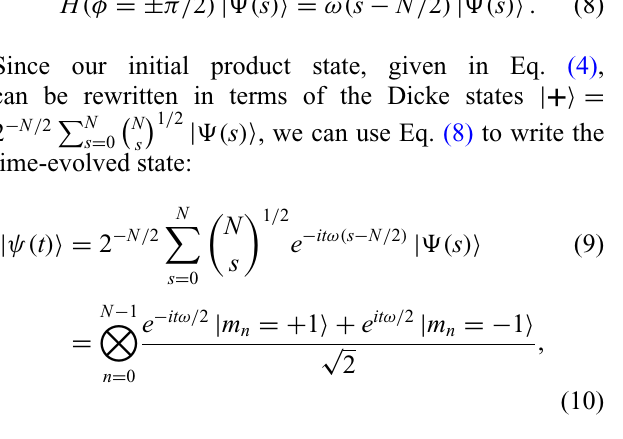
FIG. 2. (a) The optimized error δω ∗ , calculated numerically for the d = 1 example with λ n . n (cid:10) = λ/( n − n (cid:10) ) 2 , periodic bound- ary conditions, and N = 10. The plots in (b) and (c) are cross sections of (a) (although for N = 12). (d), (e) The correspond- ing optimal sensing times t ∗ . The numerical data (the circles) are √ closely matched by the equations δω ∗ = 1.09 / Nt ∗ T and t ∗ = 0.53 / | λ cos φ | (the solid lines). (All plotted for ω = 1, although the error δω is independent of ω ; see Appendix